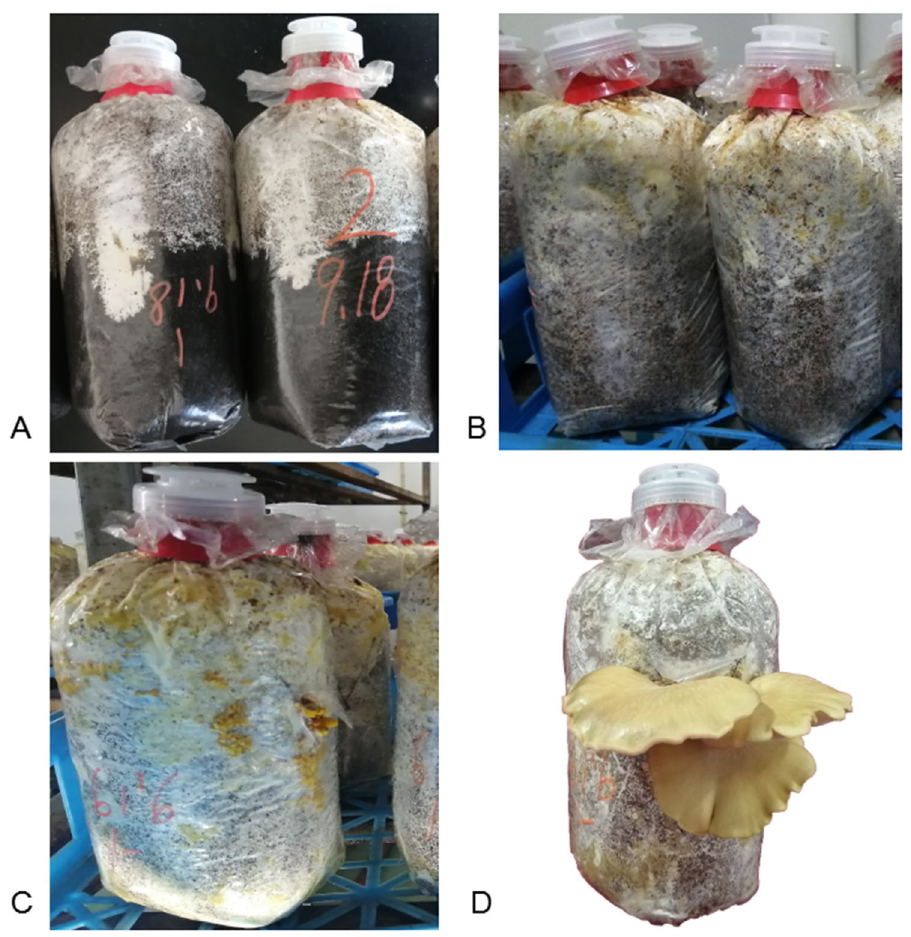
stage and mature fruiting